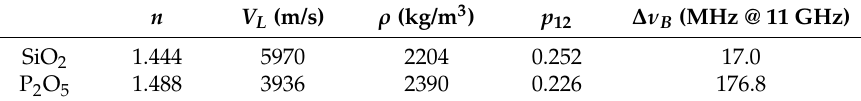
Table 3. Material properties used to calculate g B for the binary phosphosilicate glass.